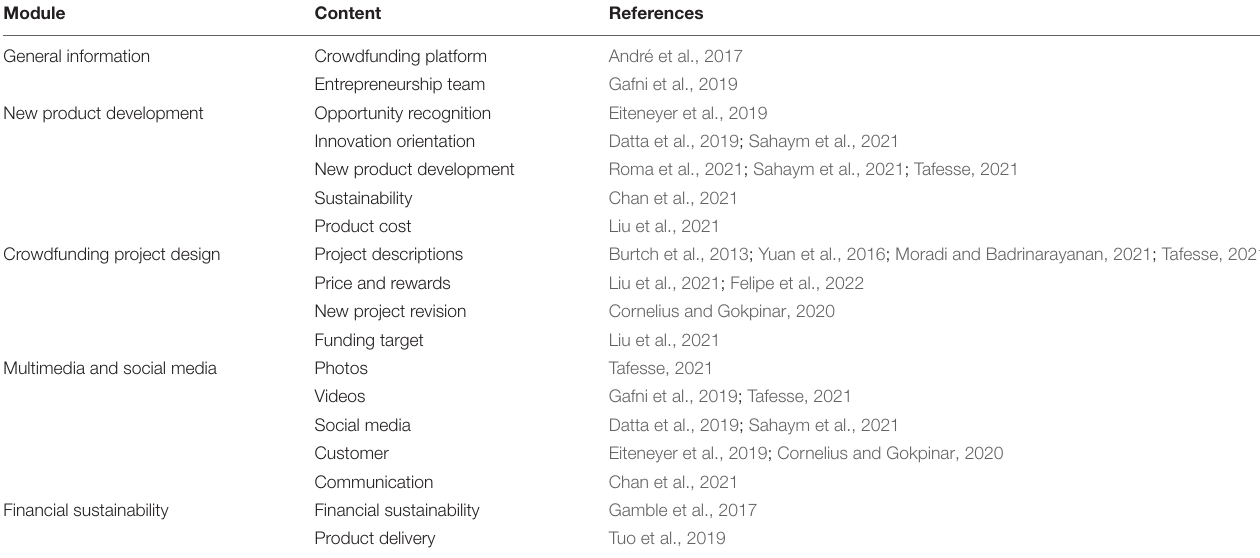
TABLE 2 | Crowdfunding curriculum